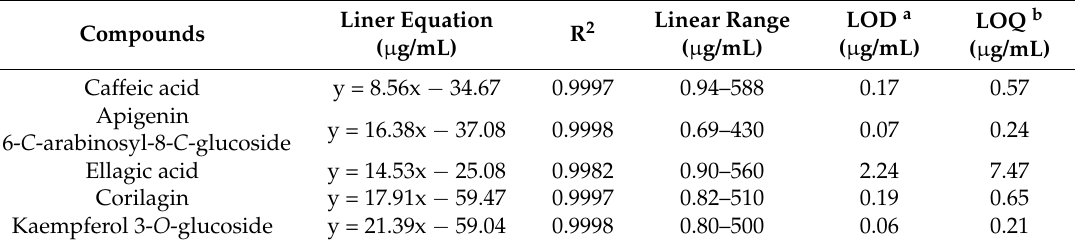
Table 2. Liner equation, correlation coefficients, limits of detection, and limits of quantification of five representative phenolic